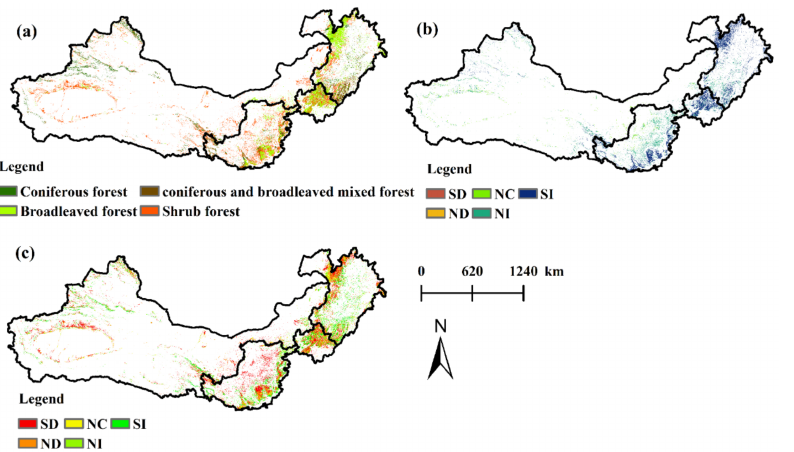
Figure 6. Distribution of forest type and dynamic change in forest quality in ecological